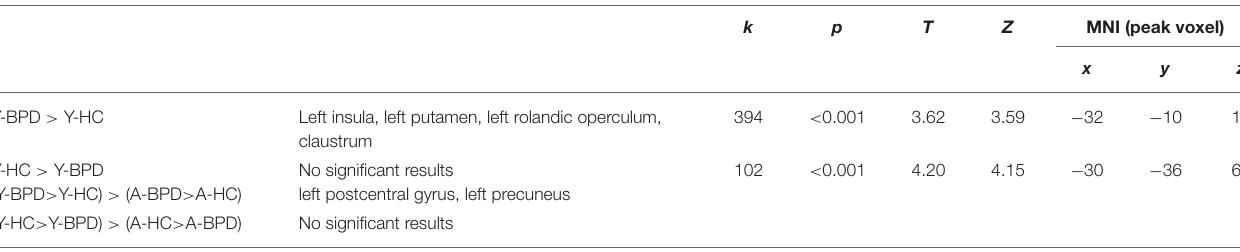
TABLE 3 | Full-Factorial Analysis, whole brain results during anger induction phase, p < 0.001 and cluster size k ≥ 88. Y-BPD > Y-HC Left insula, left putamen, left rolandic operculum, claustrum